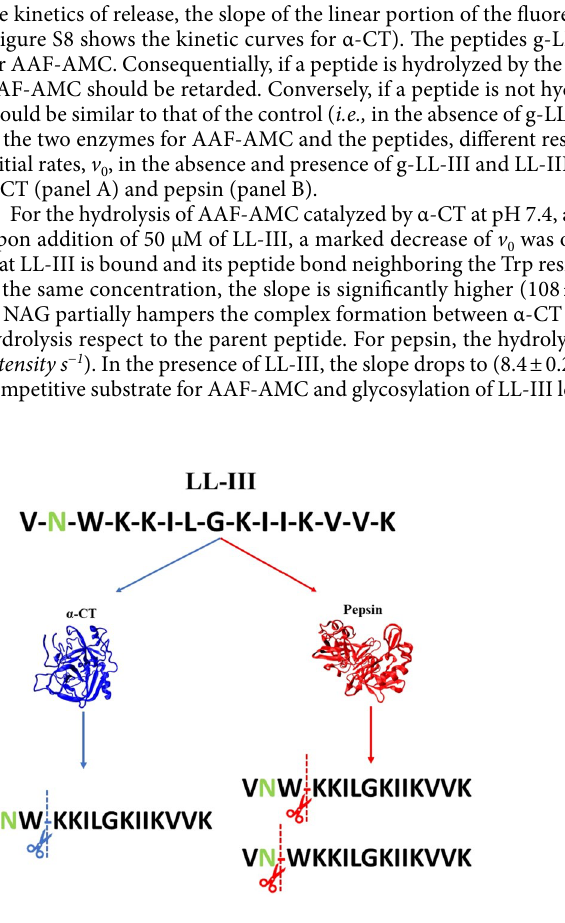
Figure 6. Hydrolysis sites of peptide bonds in LL-III peptide catalyzed by α-CT (right side) and pepsin (left side). The enzyme α-CT hydrolyzes the peptide bond at the C-terminus of the Trp residue (position 3). Instead, pepsin acts at the level of positions 2 and 3. The Asn residue is highlighted in green, to which NAG is covalently linked. The structures of α-CT (pdb code: 1ACB) and pepsin (pdb code: 4PEP) were drawn using VMD software 62,63 . The prediction of hydrolysis sites on the peptides was performed with PeptideCutter software 58